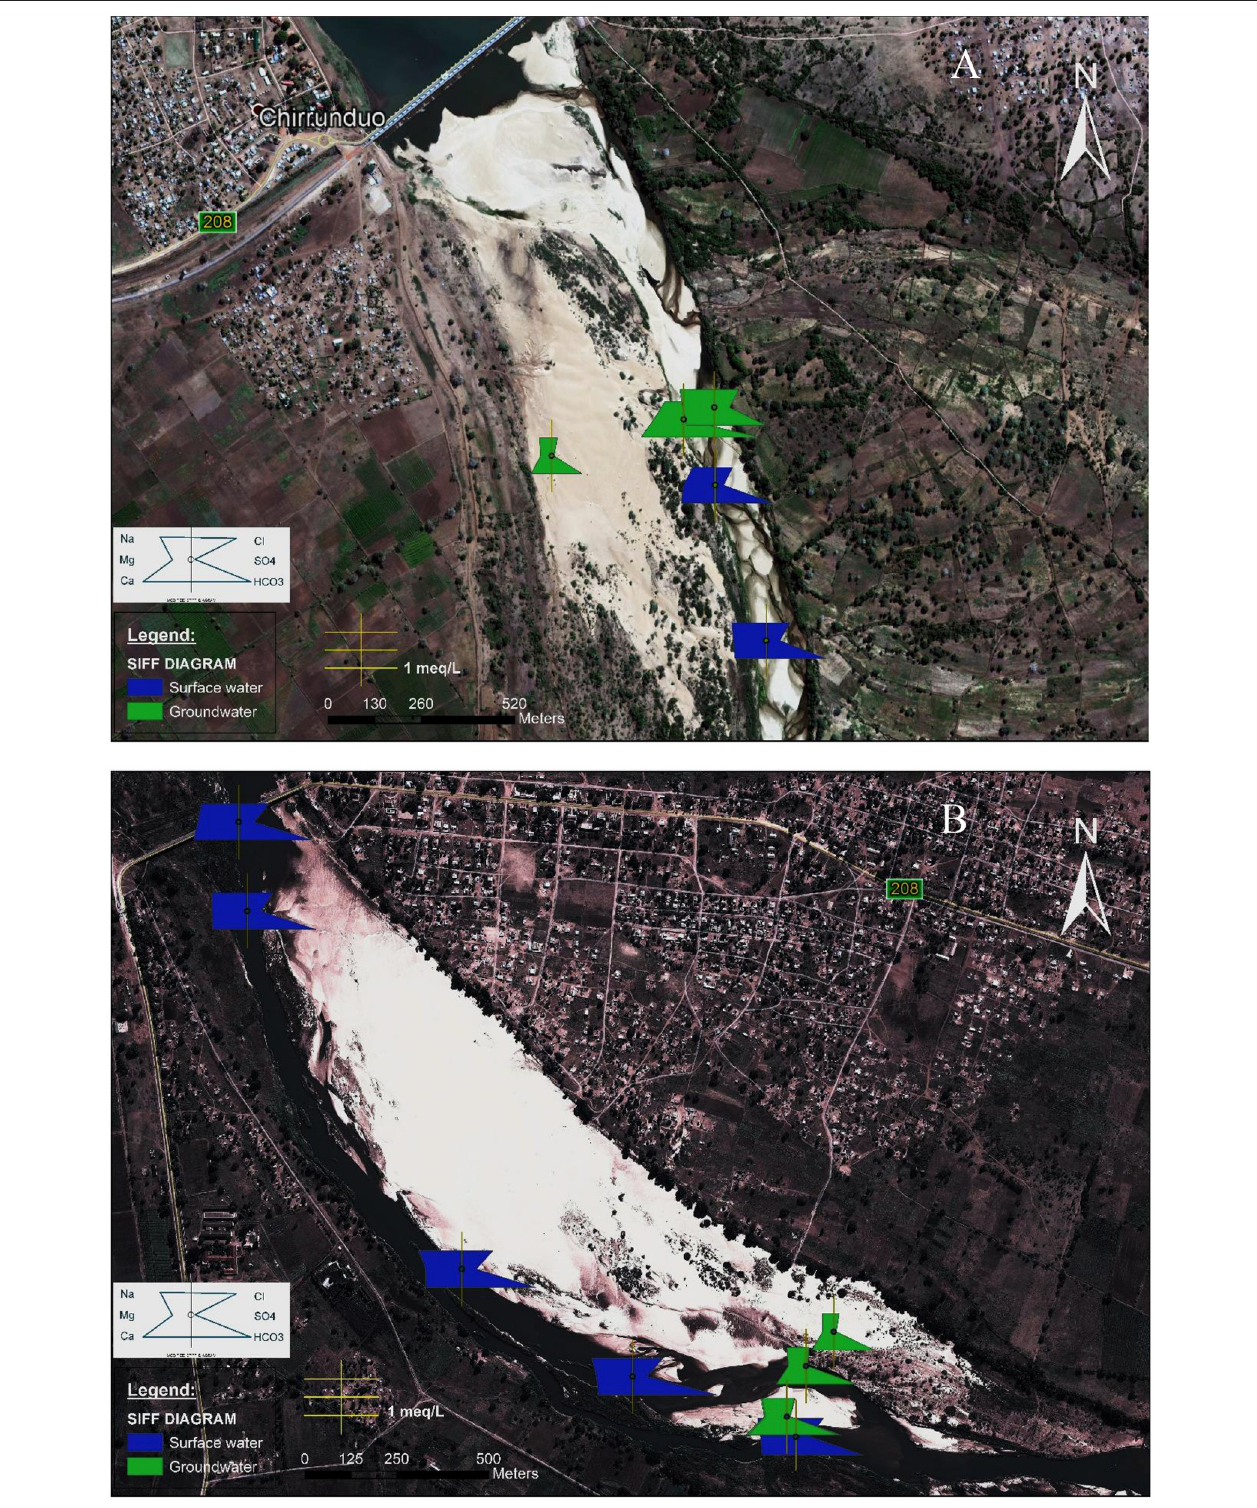
FIGURE 9 | Stiff diagrams of groundwater and surface water samples and their location in Chókwè (A) and Guijá (B) . Base map derived from satellite imagery Google Earth pro 2017, Map data: Google, DigitalGlobe 2017.